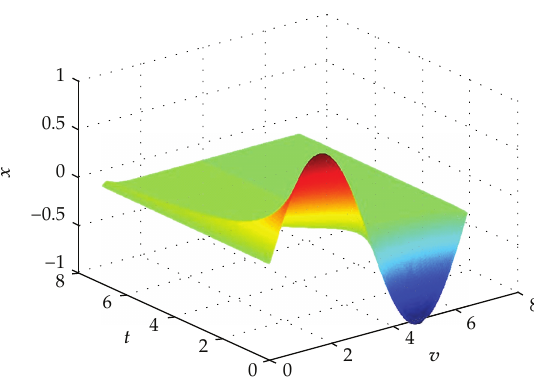
Figure 1: Numerical solution of (cid:3) 2.22 (cid:4) by 2-stage Gauss-type